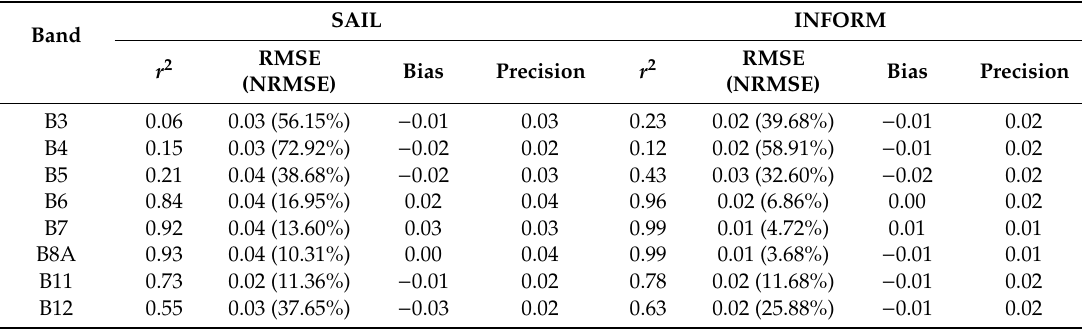
Table 6. Performance statistics for modelled SAIL and INFORM reflectance values when evaluated against observed MSI spectra, by band ( n = 87).